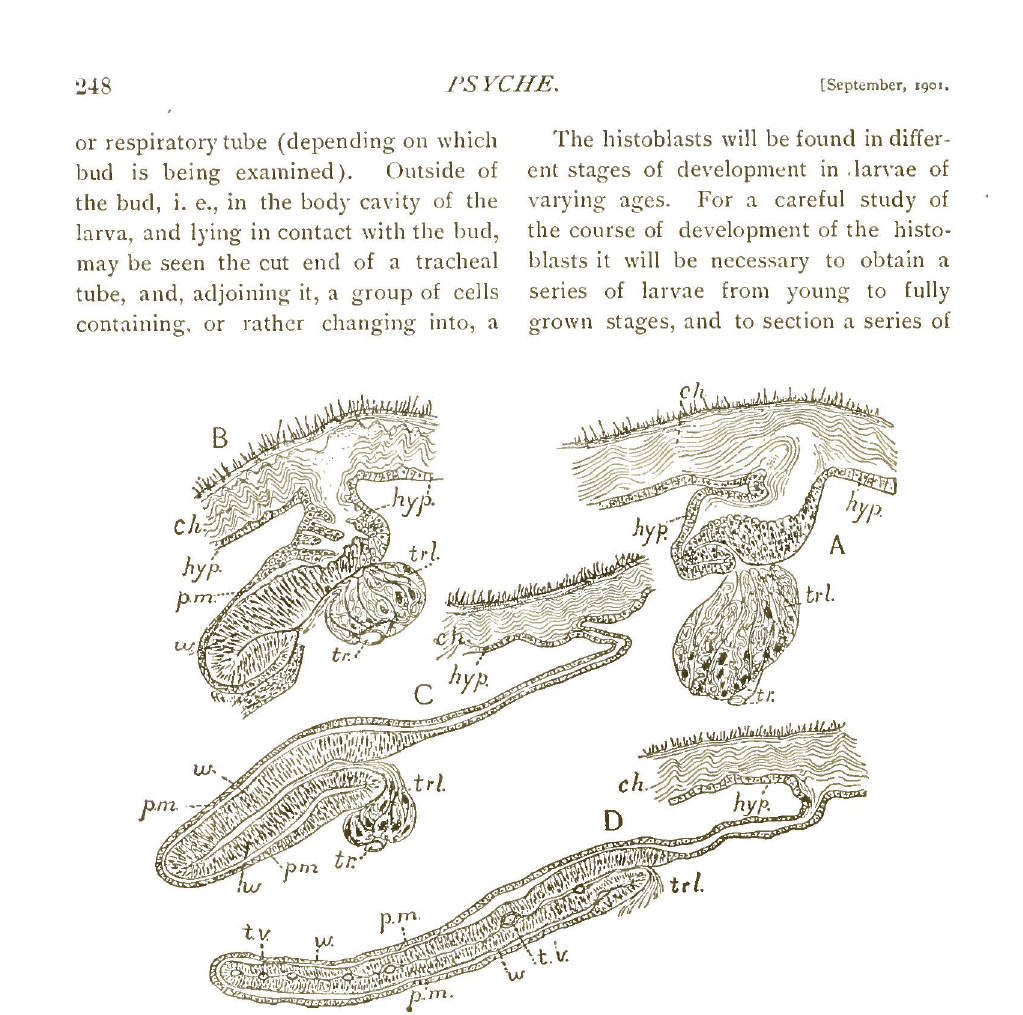
Fig. 2. Histoblast of wing of Holorust~z rubiginosa, at different stages of development, (in section); A, youngest (of the four stages) B, C, D. successively older stages; cit, chitin layer of dorsal thoracic body wall, ltyf, hypoderm, p. m. peripodal membrane, '<'V1 actual wing-forming part of the histoblast, tr, trachea, trb tracheoles, t. v, 1' tracheal vein," (each wing-vein consisting first of a tracheal tube). mass of fine capillary tubes